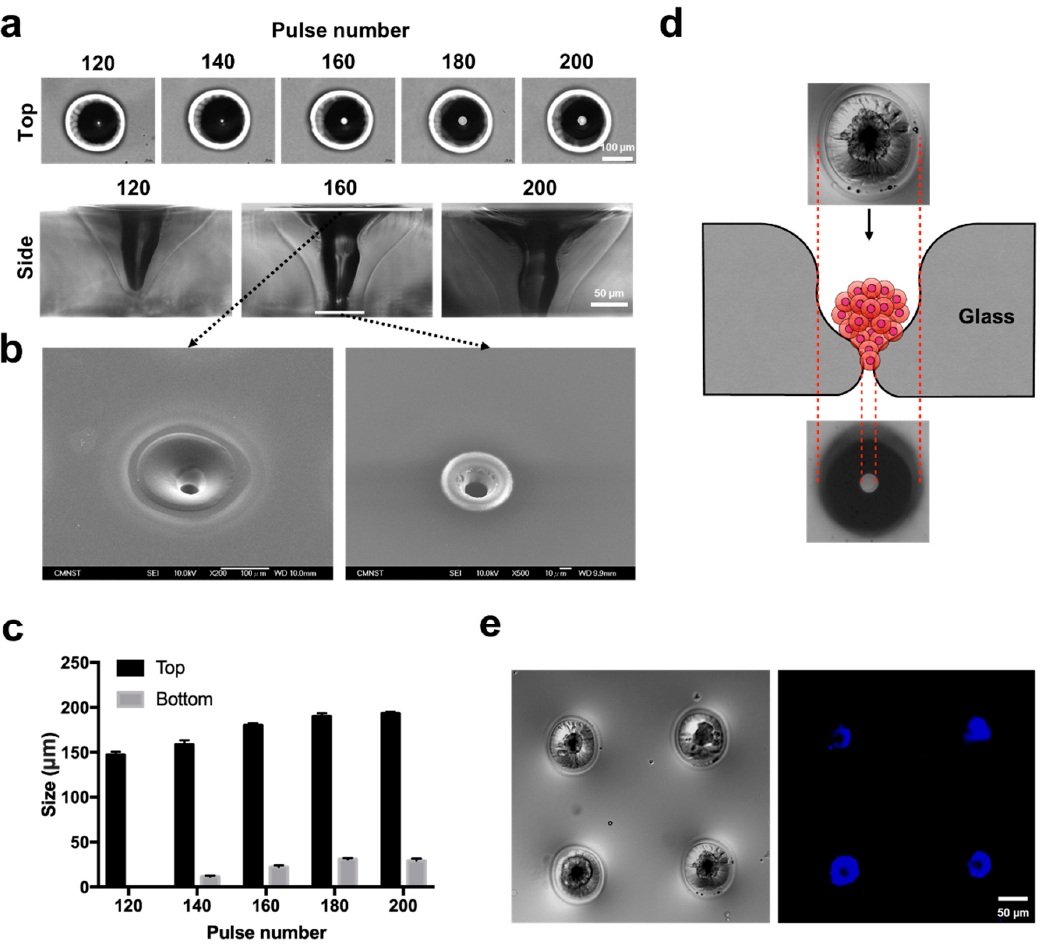
Figure 4. Microapertures formed by CO 2 laser drilling on coverglass and trapping of MCTSs. ( a ) Morphologies of glass apertures with different diameters with respect to pulse numbers ranging from 120–180. ( b ) Top and bottom views of SEM images of glass apertures drilled at a pulse number of 160. ( c ) Quantification of the diameters of top and bottom glass apertures with respect to a range of pulse numbers. ( d ) Schematic illustration of MCTS trapping by a glass aperture. ( e ) Huh7 MCTSs trapped at the neck of the hourglass shape; differential interference contrast (left) and fluorescence images of nuclei (Hoechst